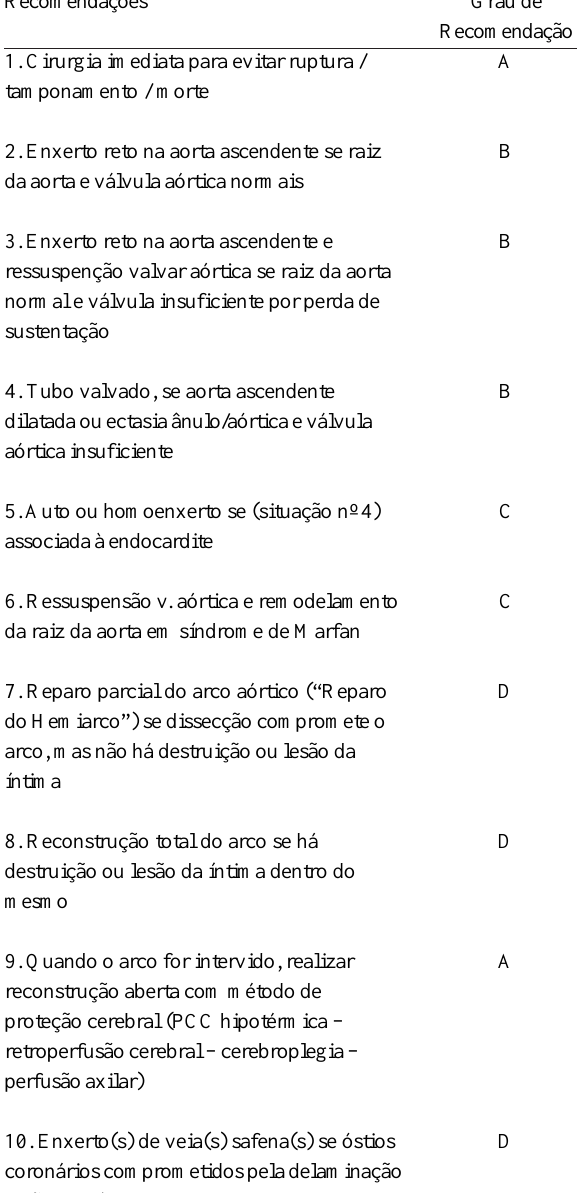
Tabela 1. Recomendações para o tratamento das Dissecções Agudas tipo